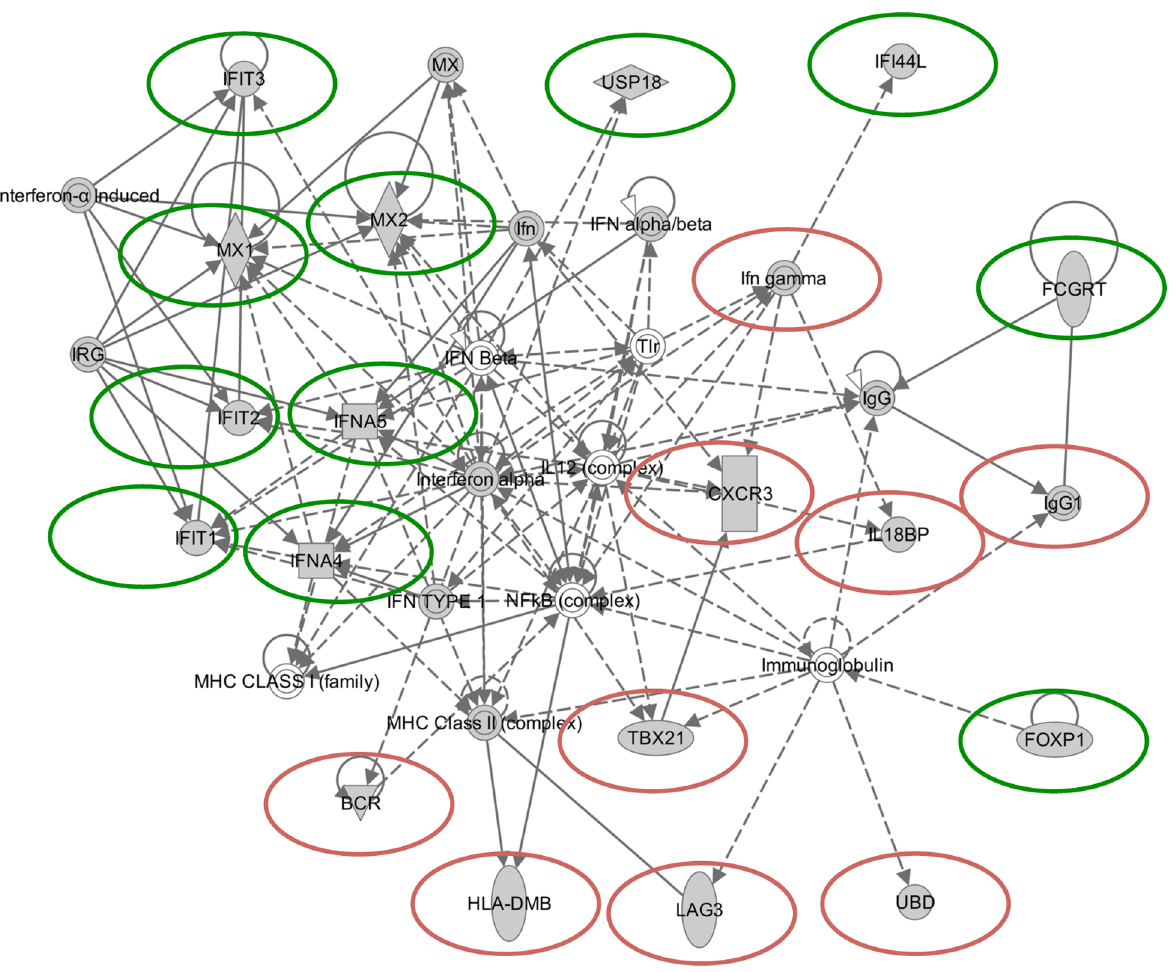
Figure 2. Graphical representation of the interactions of a subset of the genes identified by both the NSC and SVM approaches. A total of 22 genes were input into the Ingenuity pathway analysis program, and 11 are represented in this 35 gene output pathway. A detailed key to the analysis output can be found at https://analysis.ingenuity.com/pa/info/help/help.htm; which includes the following: Direct (solid lines) and indirect (dashed lines) Interaction; Inhibitory (bar at line end), Activating (arrow at line end) or Undefined (no line end) Binding; Regulation via Expression (E), Transcription (T) and Protein-protein interaction (P-P); Gene functions including Transcription regulators (wide ovals), cytokines (squares), complexes (double circles), enzymes (tall diamonds), and non-classified